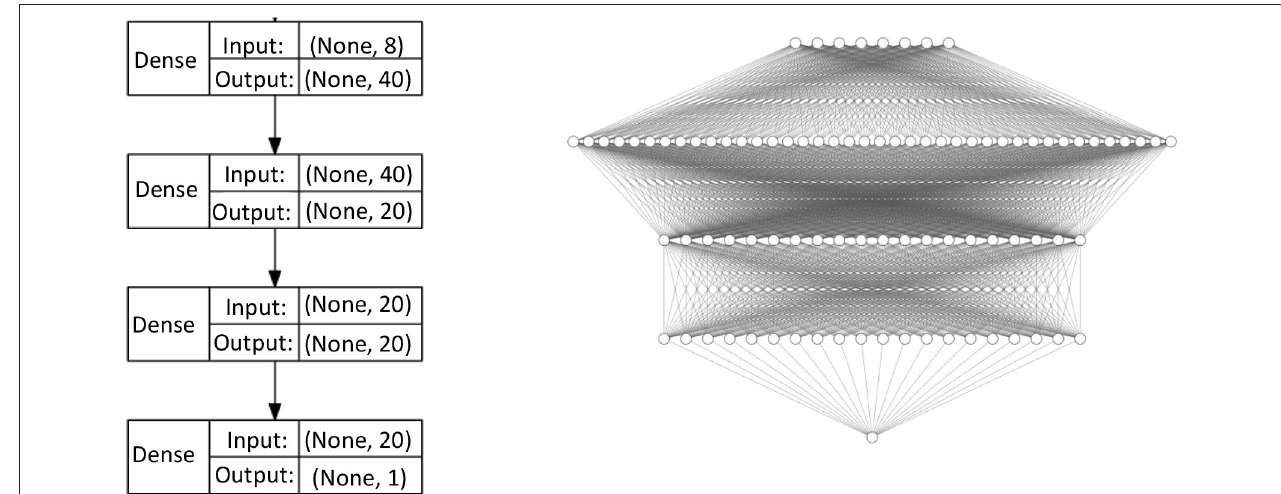
FIGURE 3 | Architecture of the ANNs used in this paper in schematical (Left) and graphical (Right)